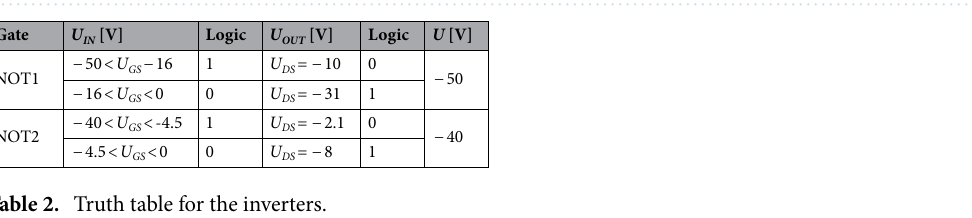
Figure 8. Electrical scheme of the NOT logic gate with three printed inverters connected in series ( a ) and predicted transfer characteristics of the gate constructed using three identical inverters: INV1 (up) or INV2 (down) ( b ).